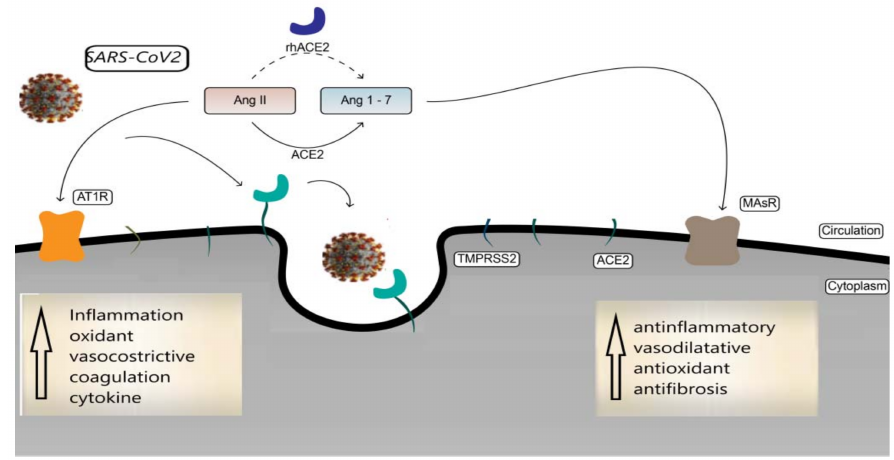
Figure 1. Schematic representation of the correlation between SARS-CoV-2 and ACE2: SARS-CoV-2 penetrates cells through binding of the viral spike protein (spike; S) to angiotensin-converting enzyme